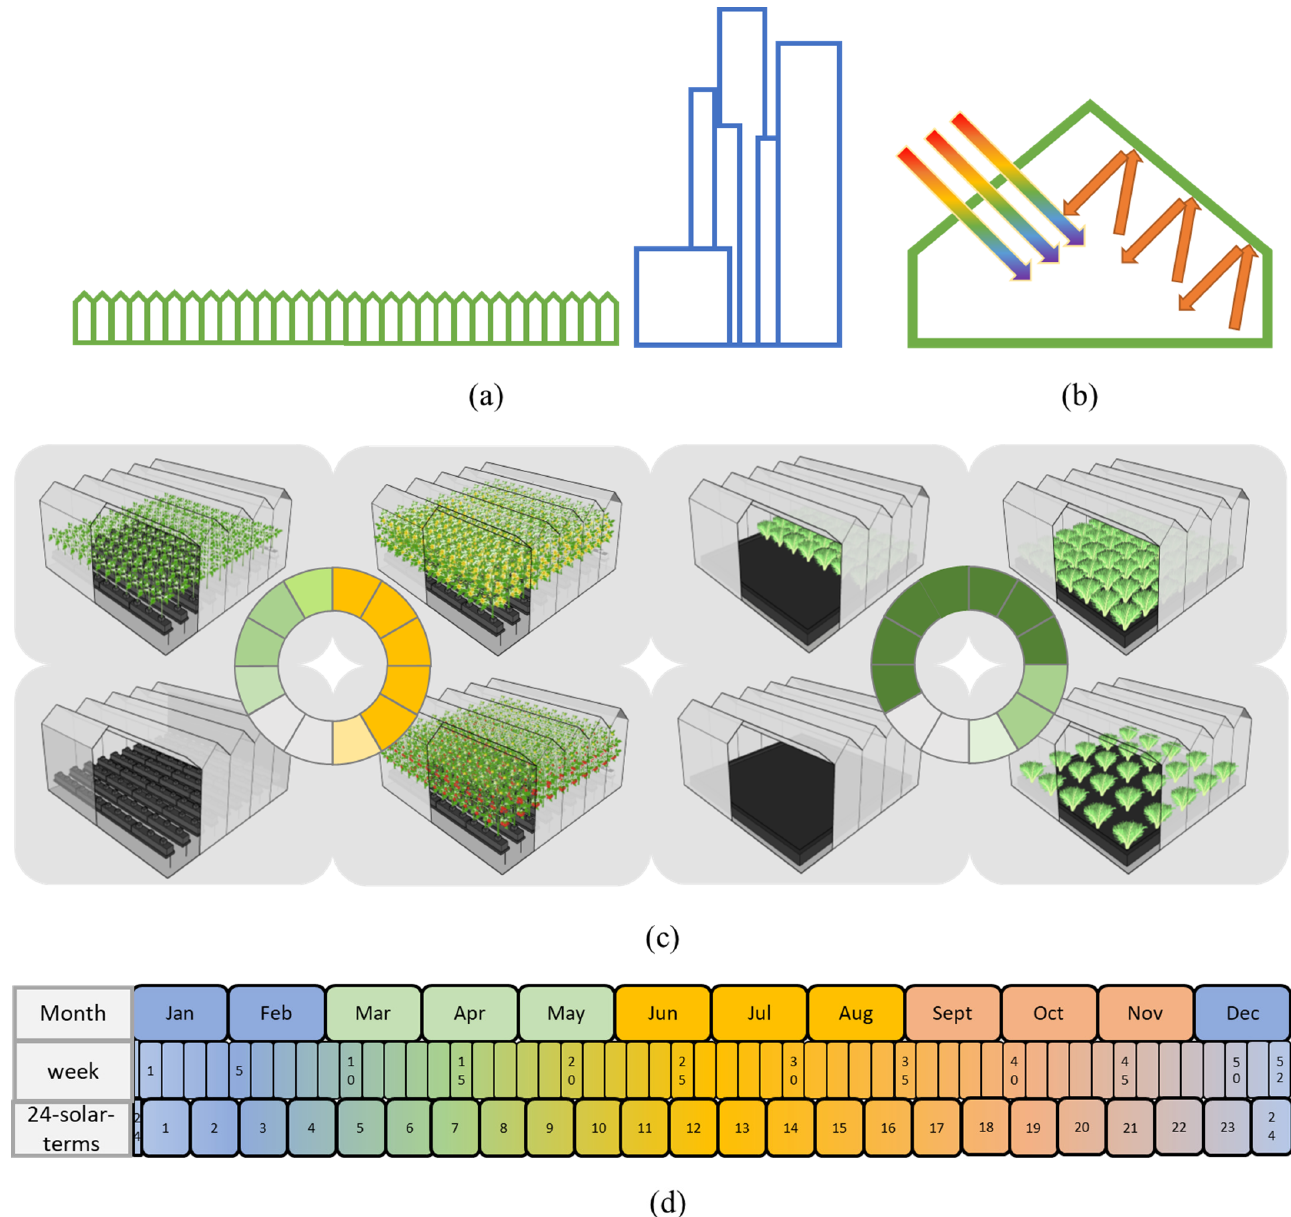
Figure 4. Characteristics of CEA buildings. ( a ) The shape and underlying surface of the CEA building area and the city. ( b ) Skin material characteristics. ( c ) The dynamic demand of tomato and lettuce greenhouses. ( d ) Calendar and season.